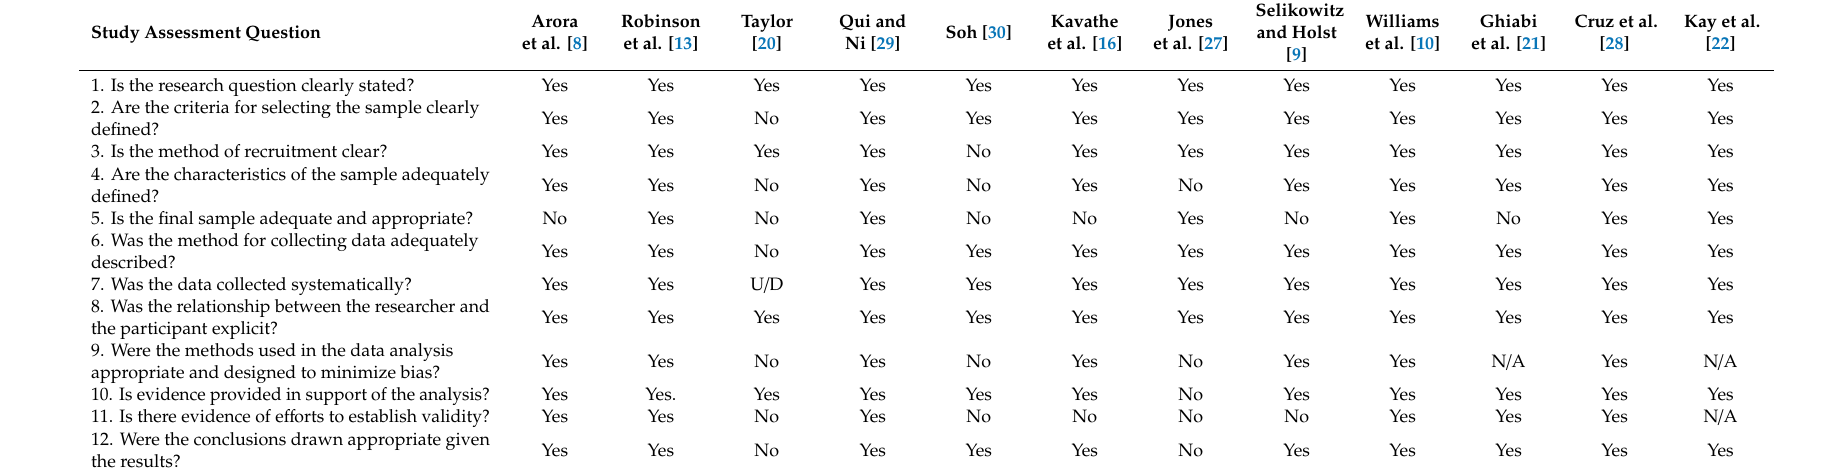
Table A3. Quality assessment for quantitative studies